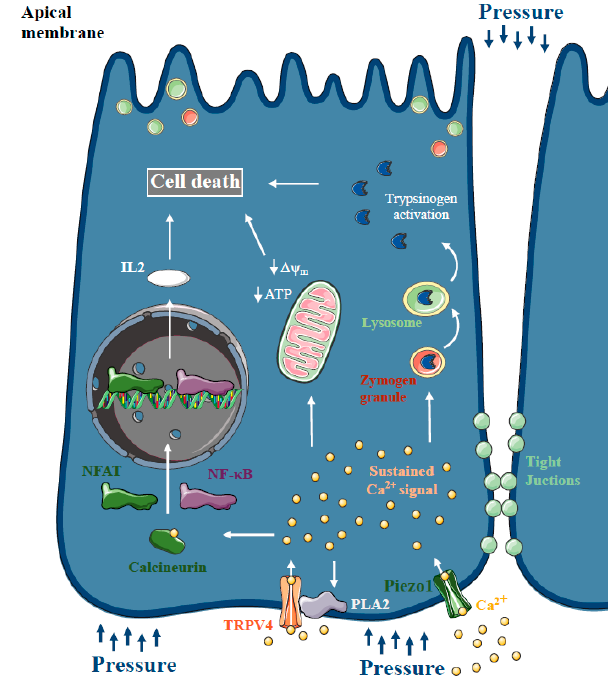
Figure 5. Ca 2+ signalling in pressure-related acute pancreatitis. Increased intrapancreatic pressure during endoscopic retrograde cholangiopancreatography (ERCP) can damage the pancreas and cause post-ERCP acute pancreatitis (AP). Similar to other forms of AP, pancreatic acinar cells represented aberrant intracellular Ca 2+ signalling and impaired mitochondrial function and calcineurin downstream activation. Recently, Piezo1 expression, a mechanoreceptor directly gated by mechanical forces, was described in pancreatic acinar cells. Piezo1 activation triggered intracellular Ca 2+ elevation and acinar cell injury. Genetic deletion of Piezo1 remarkably decreased the severity of pressure- induced AP, and it’s activation by Yoda1 triggered AP without the application of pressure. In addition, Piezo1 activation induces phospholipase A2 activation, which activates TRPV4, which is necessary for the development of sustained toxic Ca 2+ signals in acinar cells upon pressure.